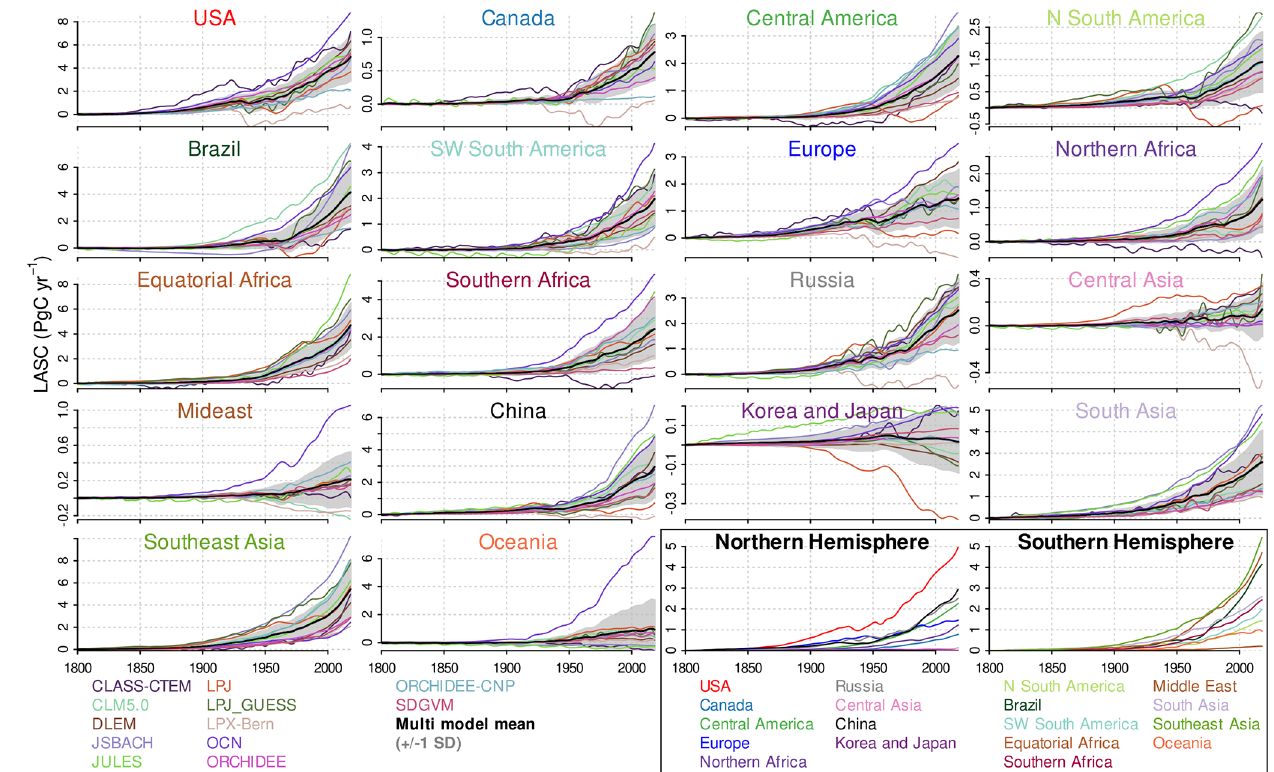
Figure A10. Region-wise smoothed cumulative loss of additional sink capacity (LASC) from 1800 onward (compare Eq. 4). For a discussion of individual models refer to Sect. A1. The last two panels show regional ensemble means on a uniform